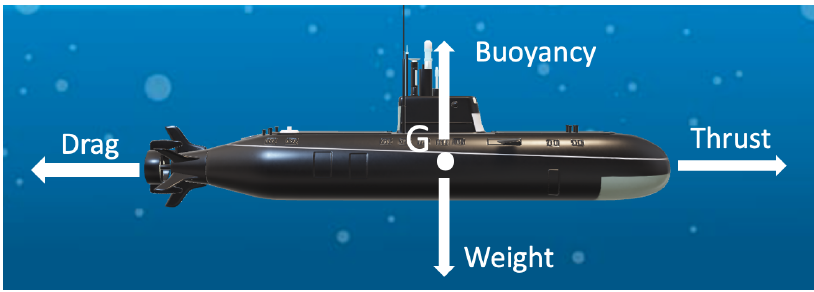
Figure 4. Free body diagram of a